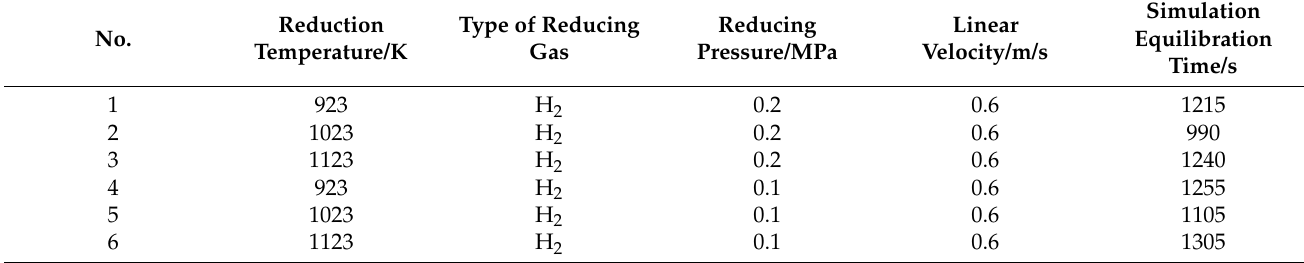
Table 6. Experimental scheme and results.